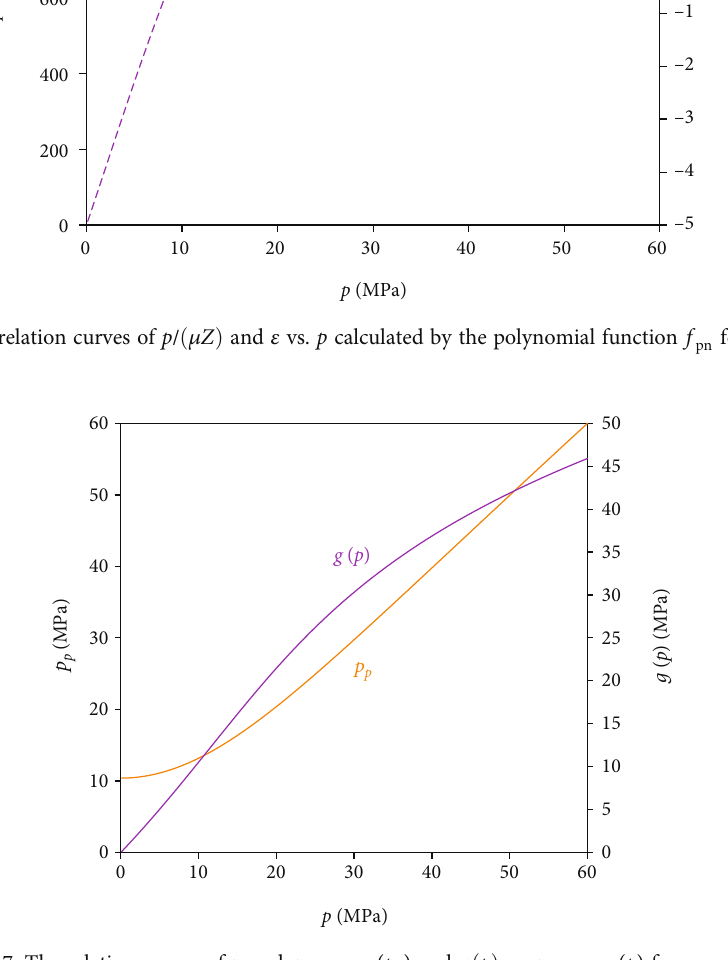
) and g ð p Þ vs. pressure ( p ) for case p